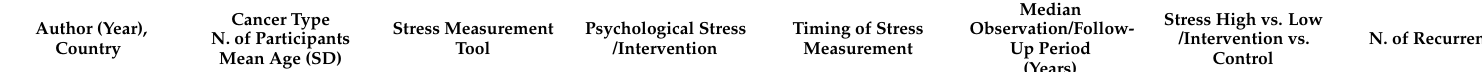
Table 1. Summary of 6 studies